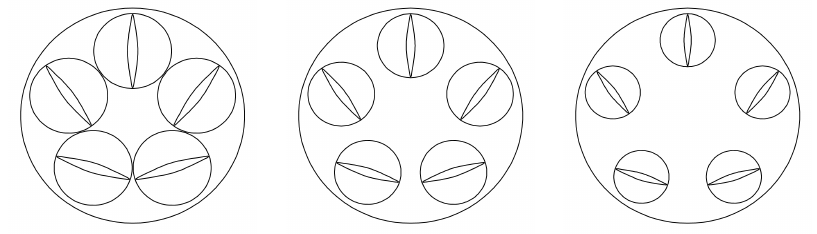
Figure 16. Blade width factors 1 ( left ), 0.85 ( middle ) and 0.7 ( right ).